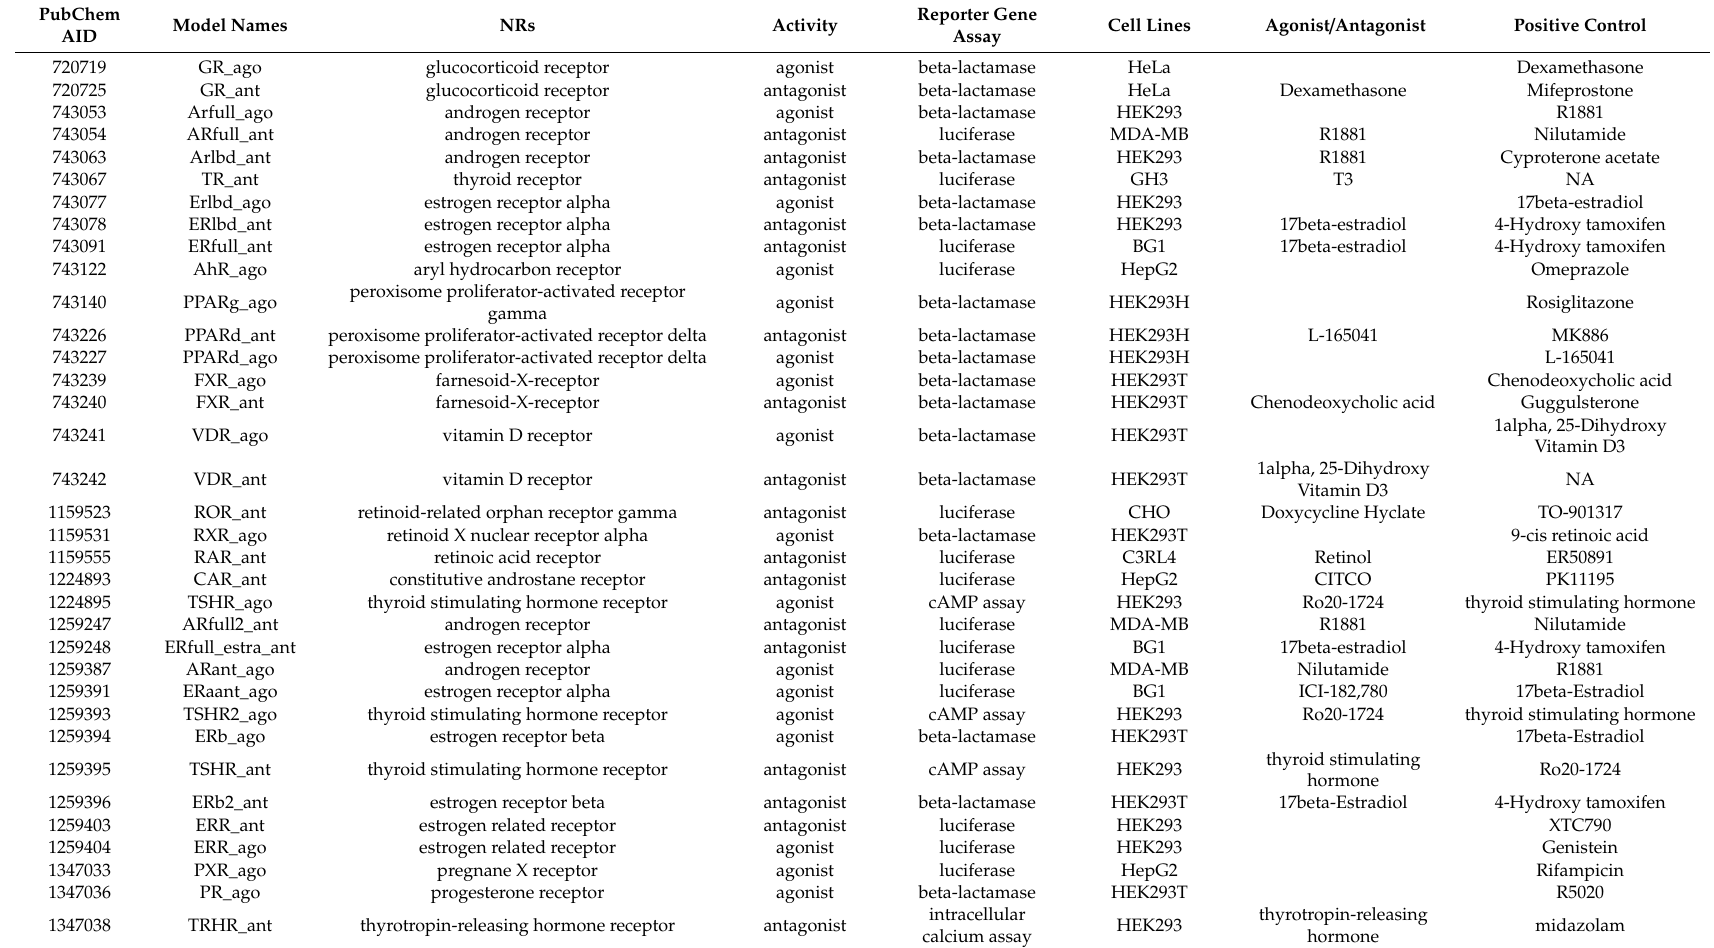
Table 1. Nuclear receptors (NRs) and their bioassays used in this